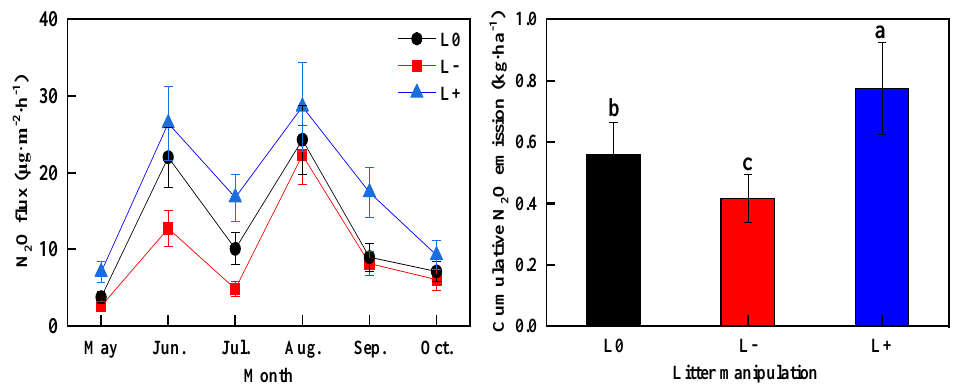
Figure 8. N 2 O fluxes and cumulative N 2 O emissions of di ff erent litter manipulation in the Larix gmelinii forest. Mean ± standard deviation. Di ff erent lowercase letters indicate significant di ff erences between manipulations in each soil layer ( p < 0.05) ( n = 9). Table 5. Pearson correlation coe ffi cients between upper layer soil characteristics and the monthly flux of N 2 O for L0, L − , and L + in the Larix gmelinii forest. Upper Layer Soil Characteristics